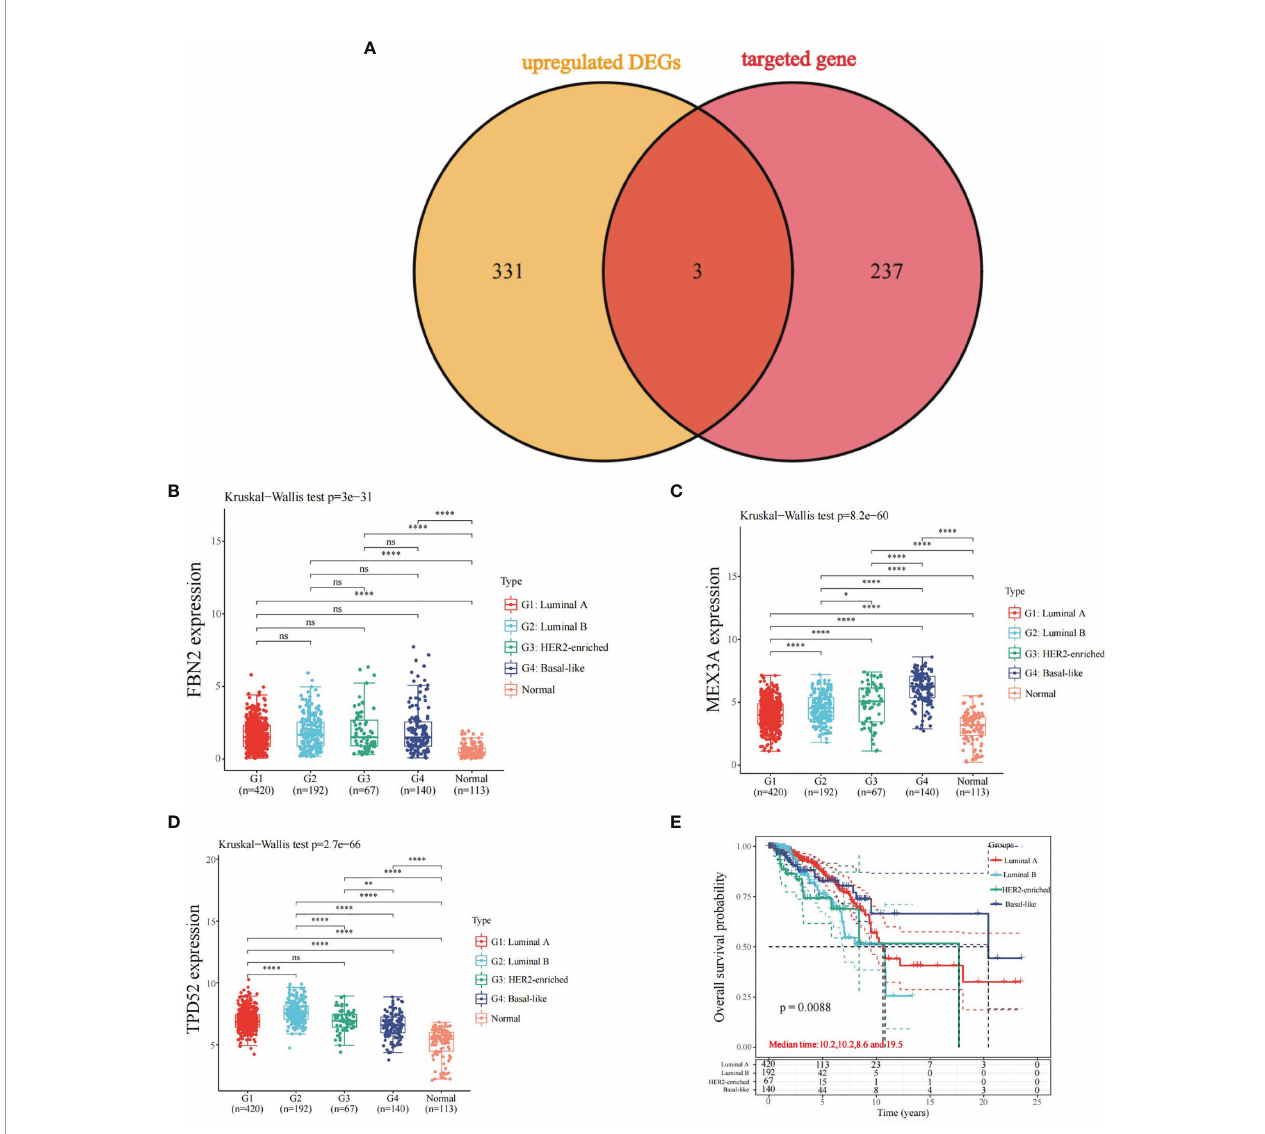
FIGURE 5 | Expression and prognosis of predicted target genes and differentially up-regulated genes. (A) Overlapping genes of predicted target genes and differentially up-regulated genes; (B) Expression of FBN2 in different types of breast cancer; (C) Expression of MEX3A in different types of breast cancer; (D) Expression of TPD52 in different types of breast cancer; (E) Overall survival time of different types of breast cancer; *P < 0.05, ****P < 0.0001. ns, no signi fi